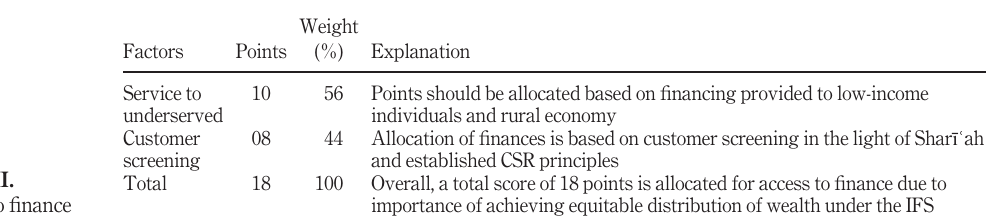
Table III. Access to fi